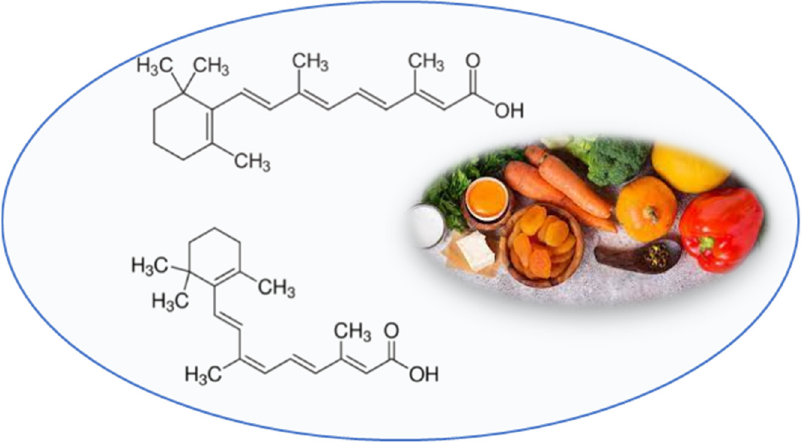
Figure 3. Chemical structures of all-trans-retinoic acid ( upper ) and 9-cis retinoic acid ( lower ). They represent preformed vitamin A which is found in meat, poultry, fish and dairy products [50]. The recommended dietary allowance (RDA) for vitamin A is given as retinol activity equivalents (RAE) and a concentration of around 900 RAE in adults should be sufficient to meet the nutrient requirements of healthy individuals [51]. After ingestion and intestinal absorption by mucosal cells, retinoids are metabolized through several enzymatic processes and retinyl esters mainly stored in the liver. Retinol is released from retinyl esters in the blood and delivered to target tissues by retinol-binding protein (RBP). Both serum retinol and serum RBP are considered the gold standard for vitamin A status